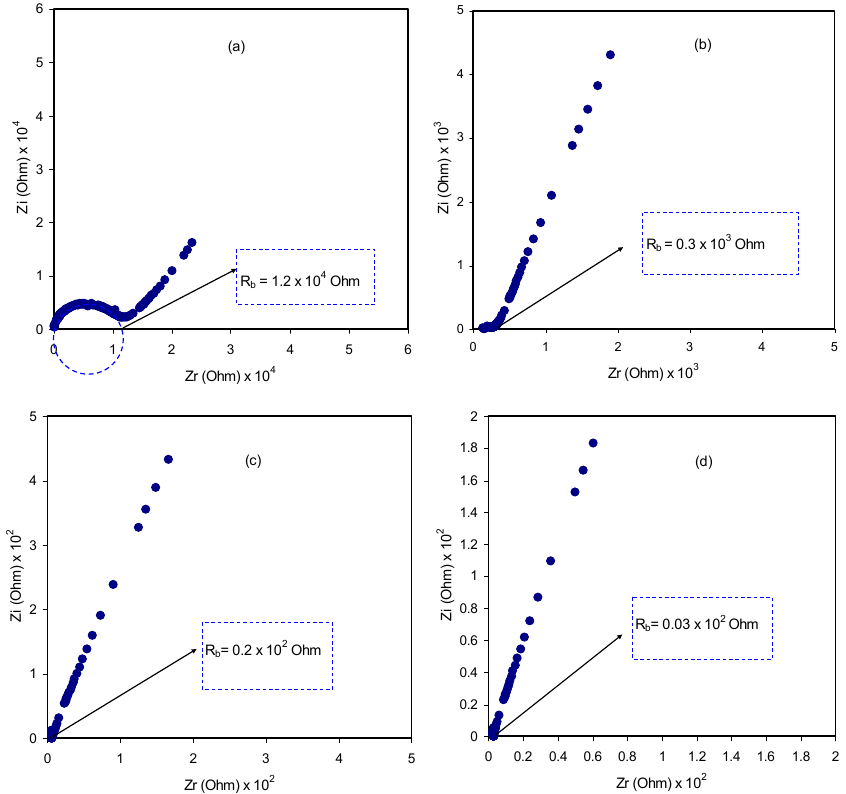
Figure 5. Impedance plots of ( a ) CMCF1, ( b ) CMCF2, ( c ) CMCF3 and ( d ) CMCF4 blended films at ambient temperature.